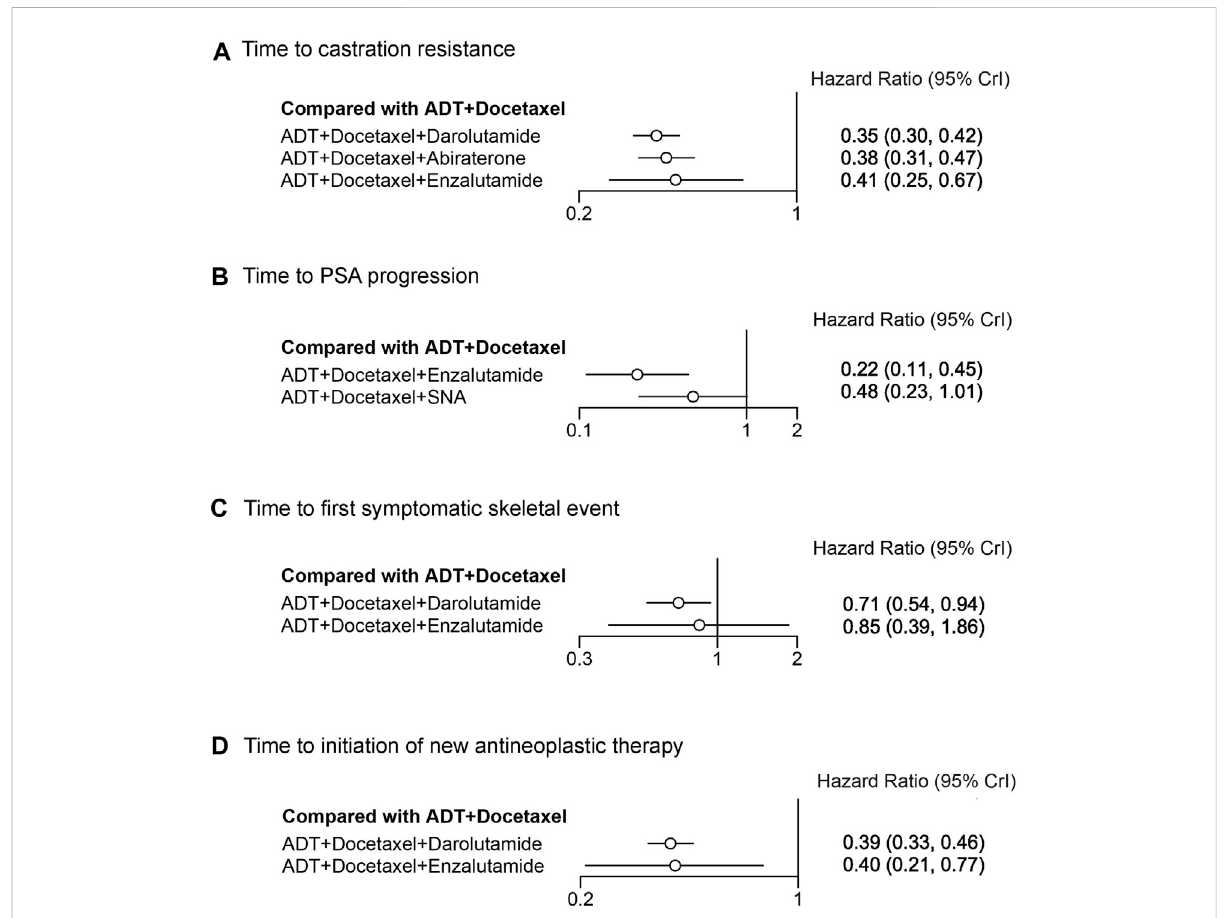
Forest plot representing a comparison of systemic triplet therapy for improving secondary endpoints compared with ADT plus docetaxel. HR and 95% CrI are represented. (A) Time to castration resistance; (B) time to PSA progression; (C) time to the fi rst symptomatic skeletal event; (D) time to initiation of new antineoplastic